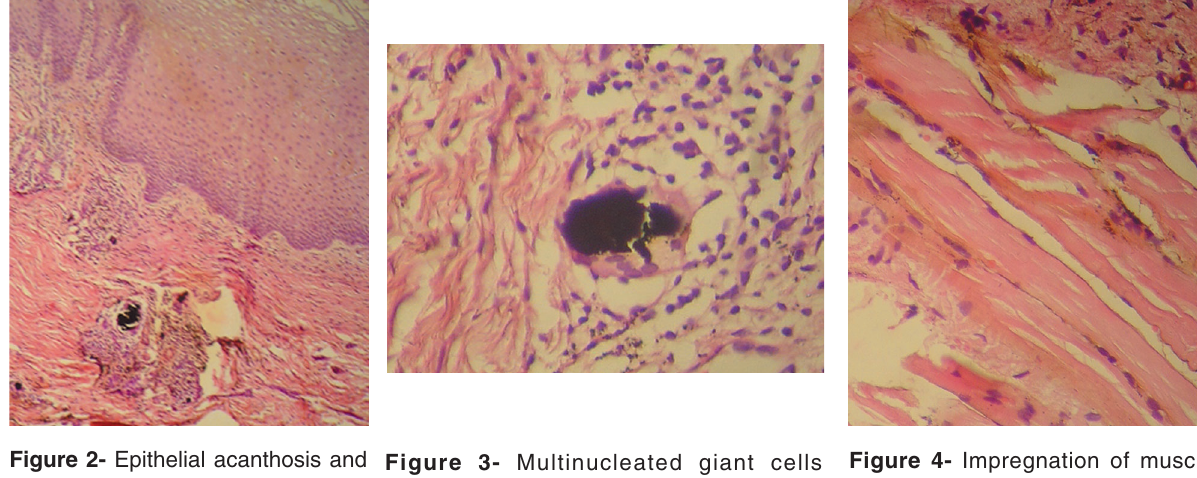
Figure 3- Multinucleated giant cells phagocyting brownish-black pigments (Hematoxylin and eosin, ×400)